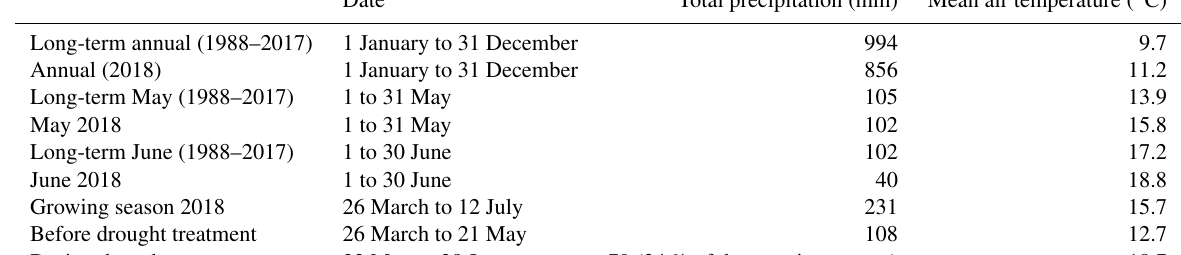
Table 1. Precipitation and air temperature data from a nearby weather station, Zürich/Kloten (KLO; 47.48 ◦ N, 8.54 ◦ E; 4.6km north of the research site; MeteoSwiss, 2020) as well as dates for the growing season (from sowing to harvest) and treatment periods in 2018.